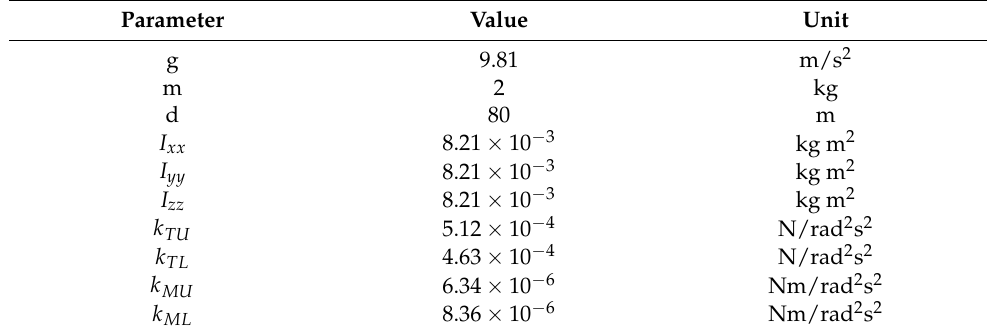
Table 1. Model parameters of coaxial rotor aircraft.